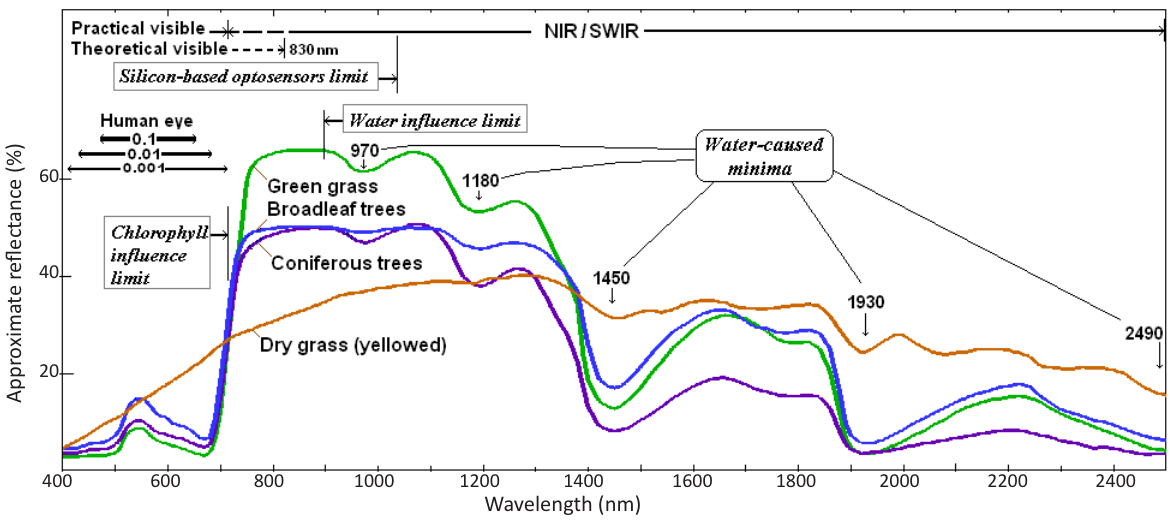
Fig. 1. Typical reflectance spectra of a natural background in the visible and infrared wavelength range of 400–2500 nm. Relative sensitivity ranges of the human eye are shown. High absorption of chlorophyll forms the characteristic 670 nm minimum that is missing from the dry grass curve. The influence of chlorophyll ends at 720 nm, which forms the red edge step. The influence of water causes five characteristic spectral minima at wavelengths above 900